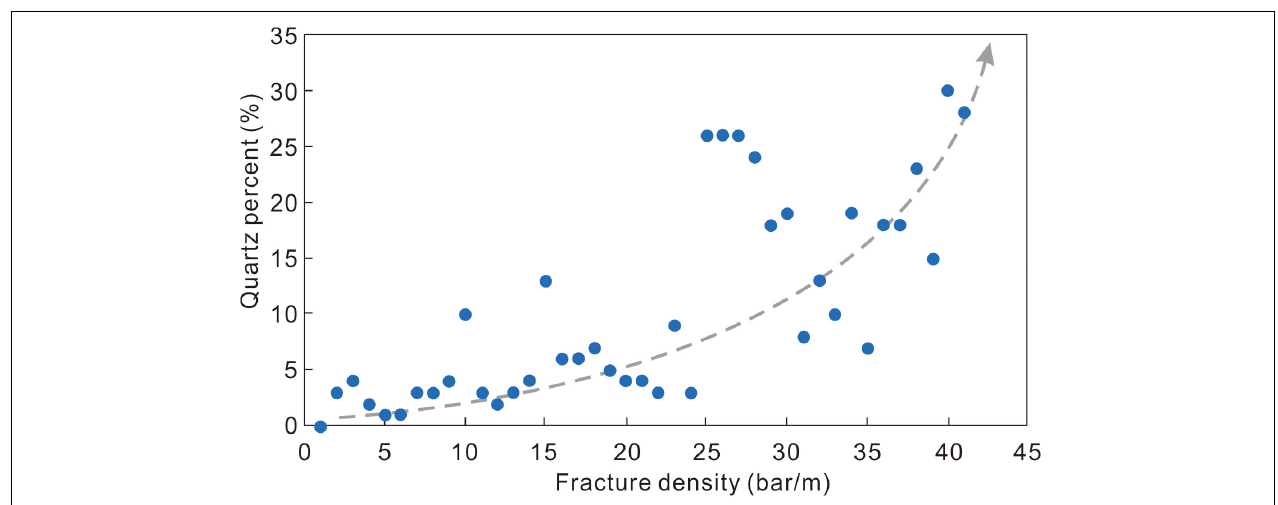
FIGURE 11 | Relationship between fracture development and quartz content in the Longmaxi Formation shale at the Yushen 8 well.